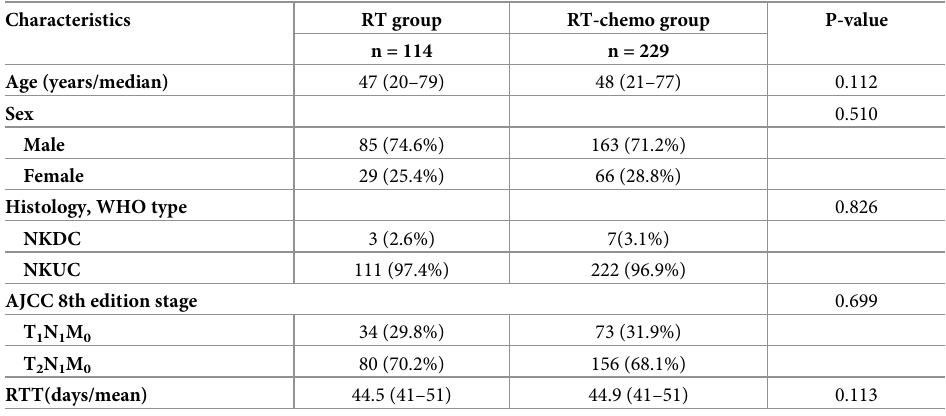
Table 1. Baseline characteristics.